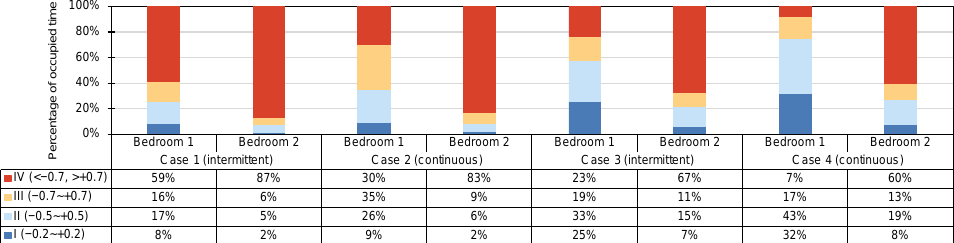
Figure 6. Proportions of bedroom PMVs during heating season in four categories of EN 16798-1:2019 standard [36].